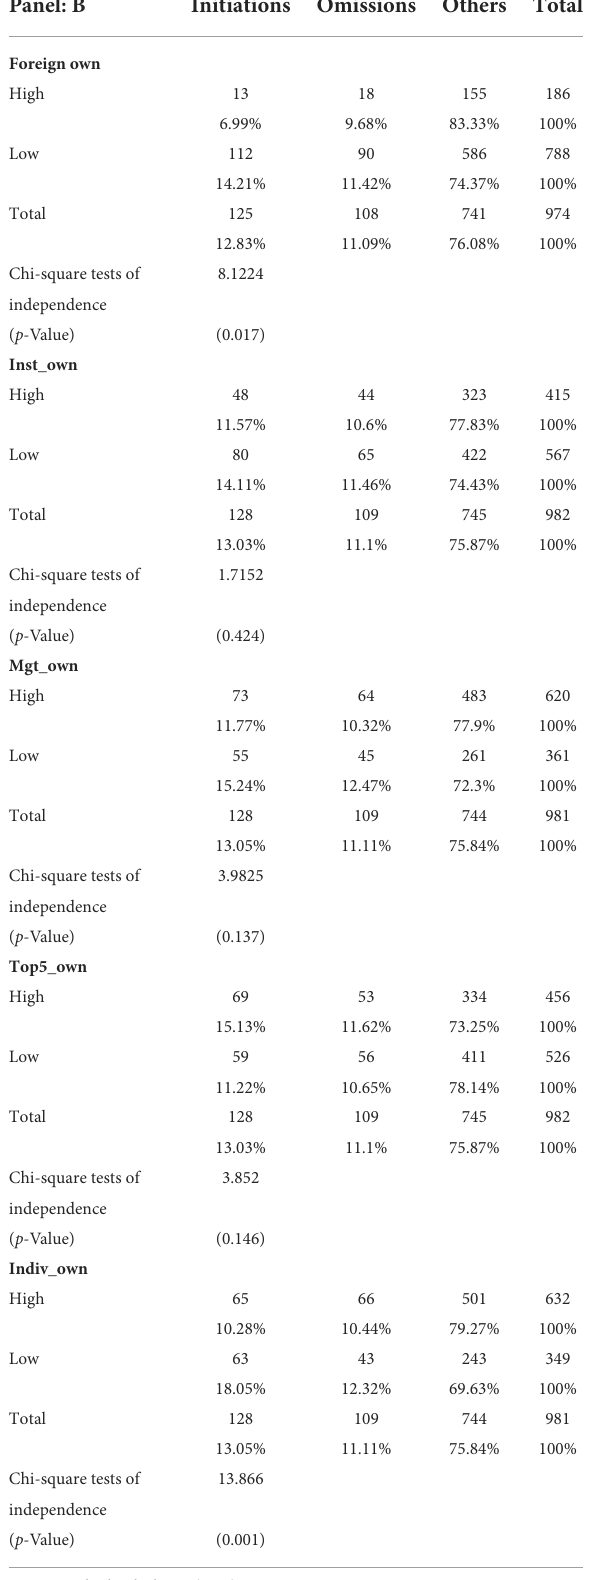
TABLE 10B Ownership structure and frequency of dividend changing